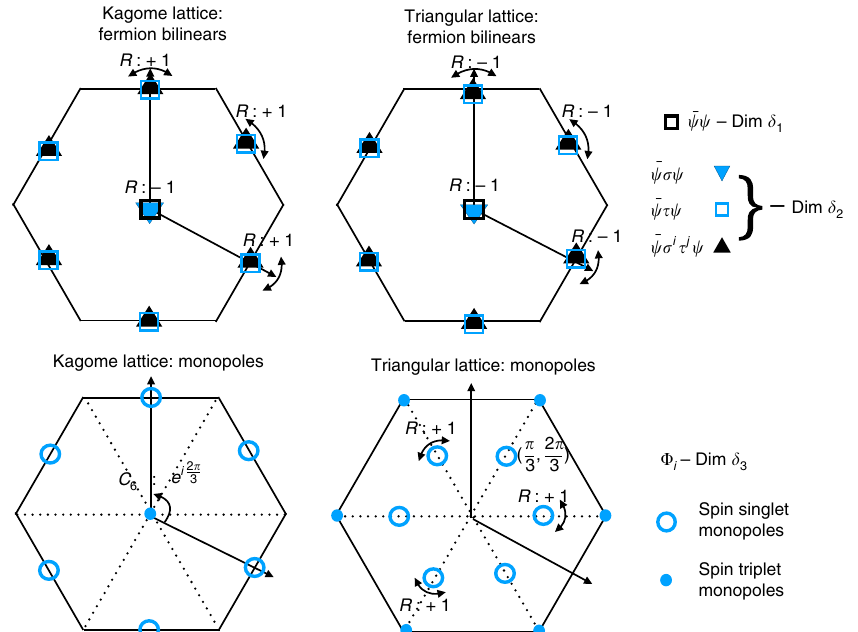
Fig. 4 Symmetry quantum numbers of dominant operators of the DSL on kagome and triangular lattices Fermion bilinears and monopoles lead to measurable characteristic signatures in numerics and scattering experiments. These include the 1 + 15 fermion bilinears and the six monopoles. In addition to translation quantum numbers (crystal momenta), rotation and re fl ection eigenvalues (where applicable) are also shown (re fl ection eigenvalues for bilinears at Γ point refer to all three re fl ection operators marked in the fi gure; note for triangular bilinears, re fl ection used is different from that in Table 2 or Fig. 1). The spin triplet monopoles on the kagome lattice have angular monentum l = 2 under C 6 . For triangular lattice monopoles, re fl ection eigenvalues apply to both spin singlet and triplet monopoles. The fermion bilinears and monopoles have different scaling dimensions as shown in the fi gure with the current best estimates indicating δ 1 > δ 2 > δ 3